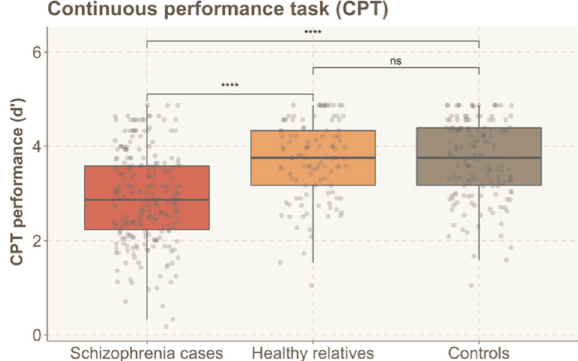
Fig. 3 Performance on CPT for the 3 groups. Patients performed signi fi cantly differently from their relatives and controls; relatives and controls performed similarly. Asterisks indicate statistically signi fi cant differences: *P < 0.05, **P ≤ 0.01, ***P ≤ 0.001, ****P ≤ 0.0001, n.s. not signi fi